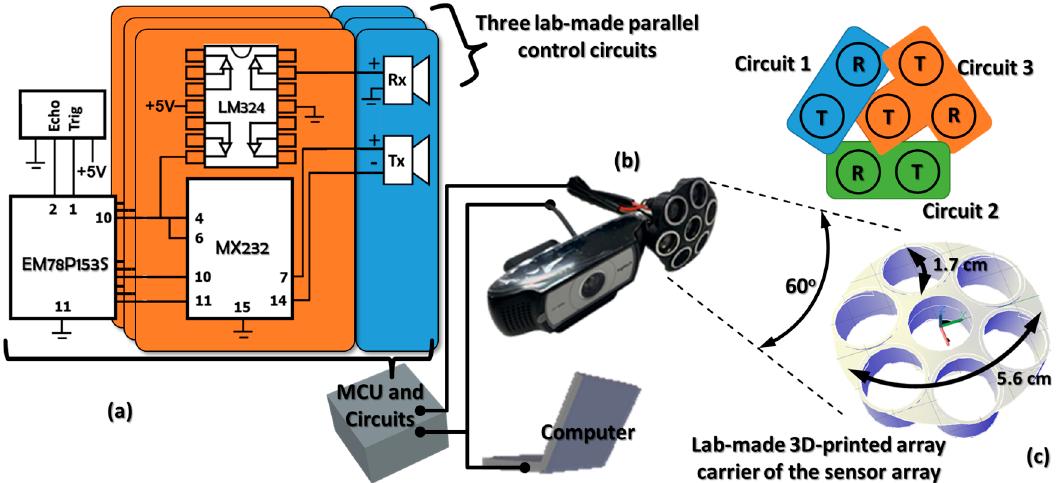
Figure 1. The structure of the proposed hybridized platform includes ( a ) the control and readout circuits of the ultrasonic sensors, ( b ) the hybridized ultrasonic and image sensors, and ( c ) the 3D-printed package of the ultrasonic sensor array. The arrangement of the ultrasonic transmitters (Tx) and receivers (Rx) is also shown in ( c ). The central transmitter has a common control scheme with one of the readout circuits.